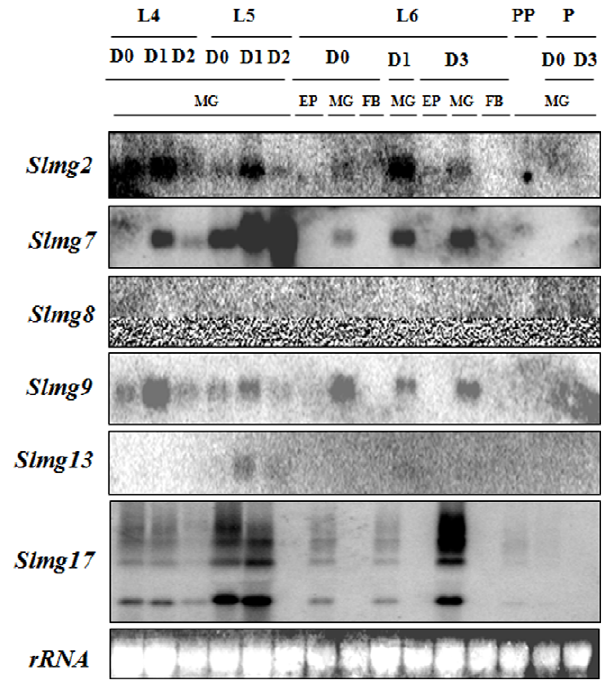
Figure 2. Northern blot analysis of expression of the six selected ESTs from 4 th to 6 th instar larvae, prepupae and pupae of S.litura . Ten micrograms of total RNA isolated from the midgut (MG), epidermis (EP) and fat body (FB) was separated on denaturing 1% MOPS-formaldehyde gel. A 32 P-labled EST fragment was used as a probe. Ethidium bromide stained rRNA indicates the equal loading of total RNA. L4D0: the day molting to 4 th instar; L4D1: day 1 at 4 th instar stage; L6D0: the day (white head) of ecdysis from 5 th to 6 th instar stage; L6D1-L3D3: 1–3 days after ecdysis into 6 th instar stage; PP: prepupal stage; P: pupal stage. MG: midgut; EP: epidermis; FB: fat body.